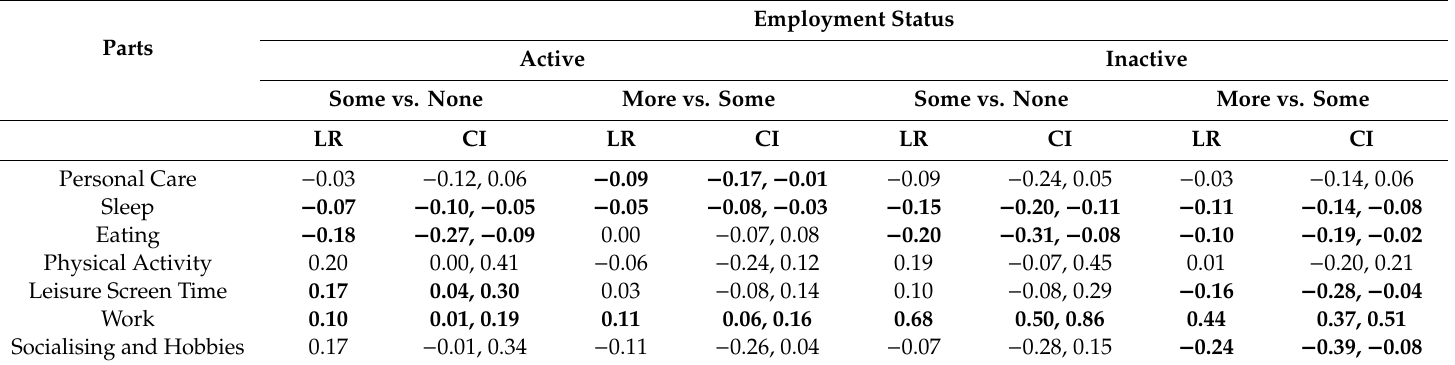
Table A4. Log-ratio di ff erence between groups and bootstrapped confidence